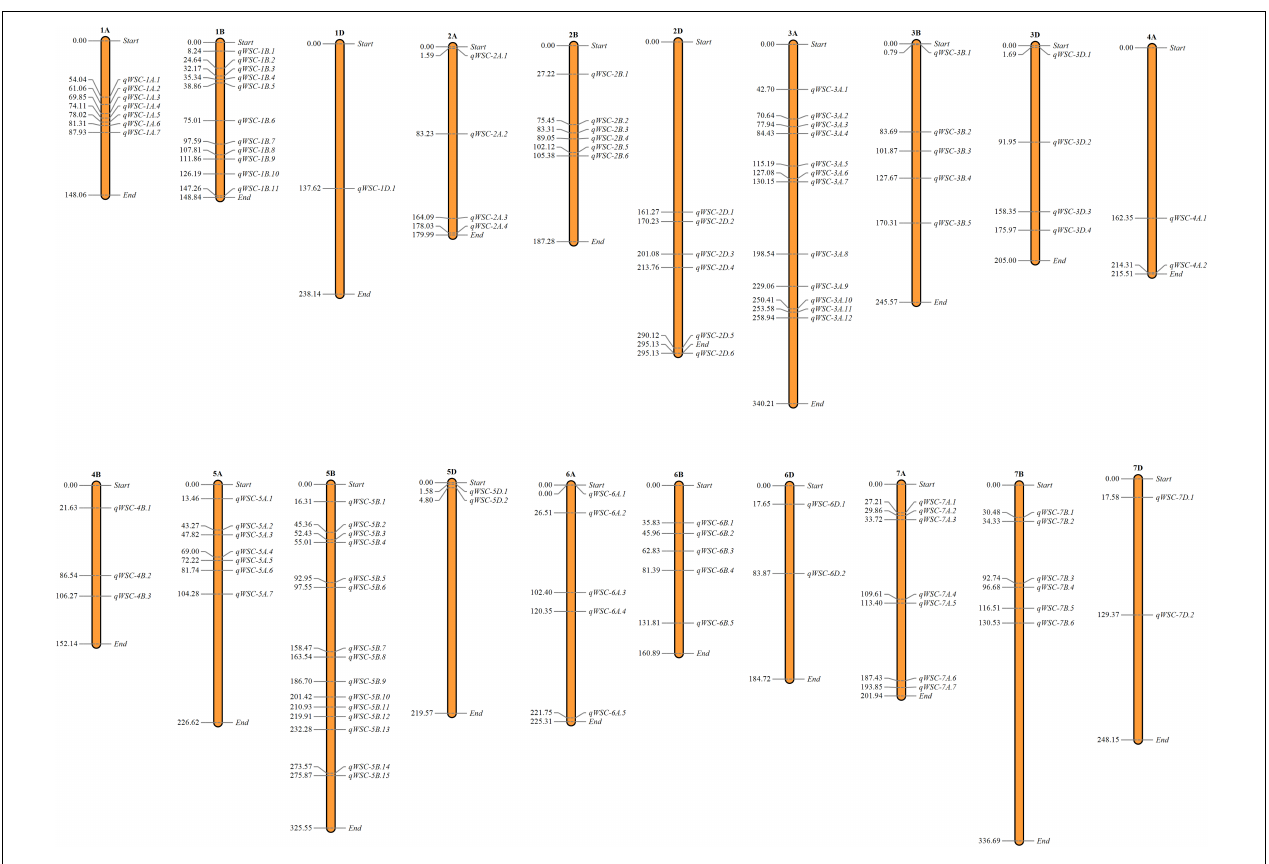
FIGURE 4 | Dispersion of detected quantitative trait nucleotide regions (QNRs) across the bread wheat genome. The number on the left denotes the position of the first quantitative trait nucleotide (QTN) detected in the respective QNRs.